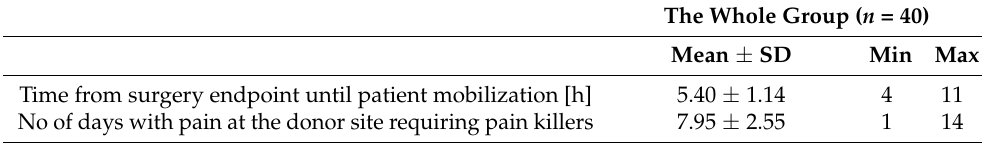
Table 3. Descriptive statistics of selected parameters characterizing the early postoperative period after the procedure of cancellous bone harvesting from the proximal tibia in the general group of patients.